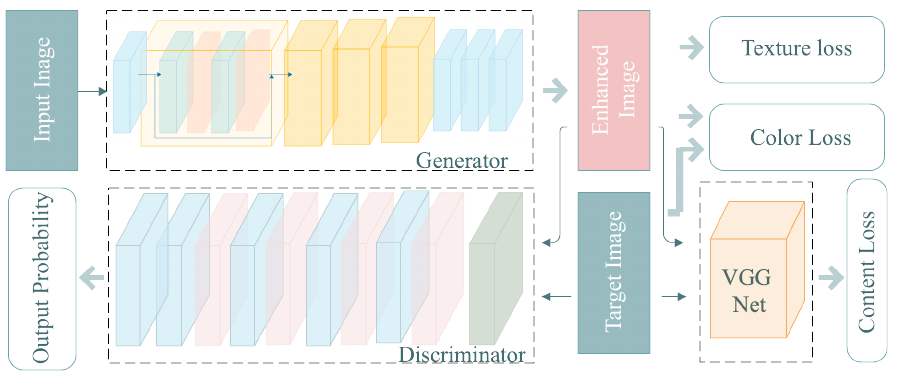
Figure 2. Architectures of the image enhancement